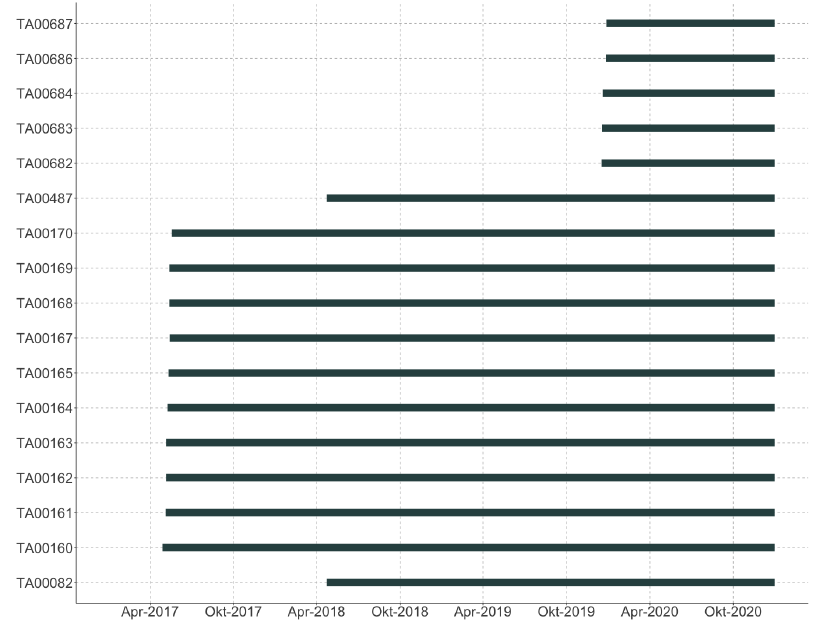
Figure A2. Begin of measurement period of the 17 preselected TAHMO stations in Burkina Faso, from which stations TA00160–TA00170 (starting from May 2017) are selected for further statistical